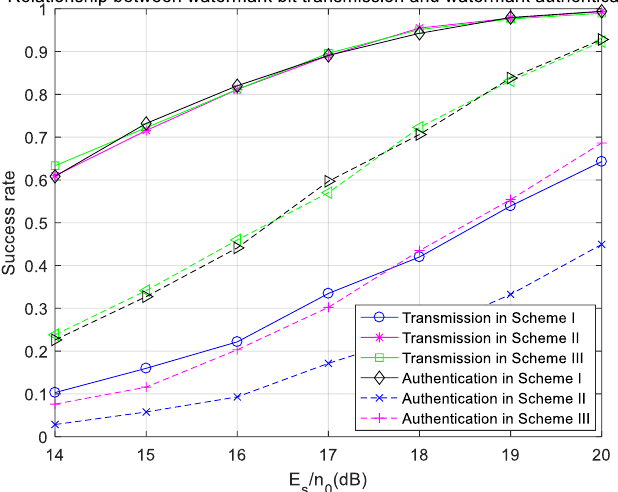
Figure 21. Success rates of watermark-bit transmission and watermark authentication with frequency offset in the fading channel.